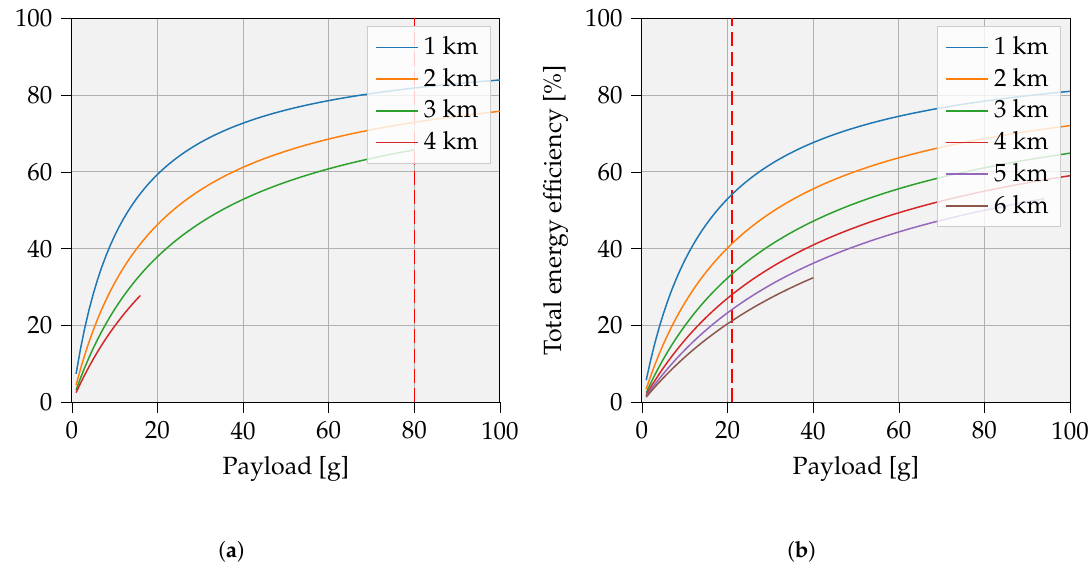
Figure 17. An NCA battery, with a weight energy density of 237Wh/kg, assumed to be transported by the UAV. Assuming the total weight of the UAV should not exceed 250g, the maximum payload of 80g (one UAV battery) and 21g (two UAV batteries) is indicated by the dotted vertical line. ( a ) One UAV battery; ( b ) two UAV